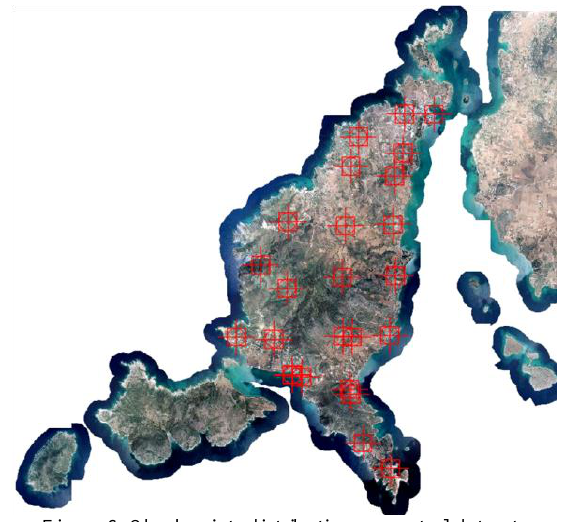
Figure 6. Checkpoints distribution on control dataset